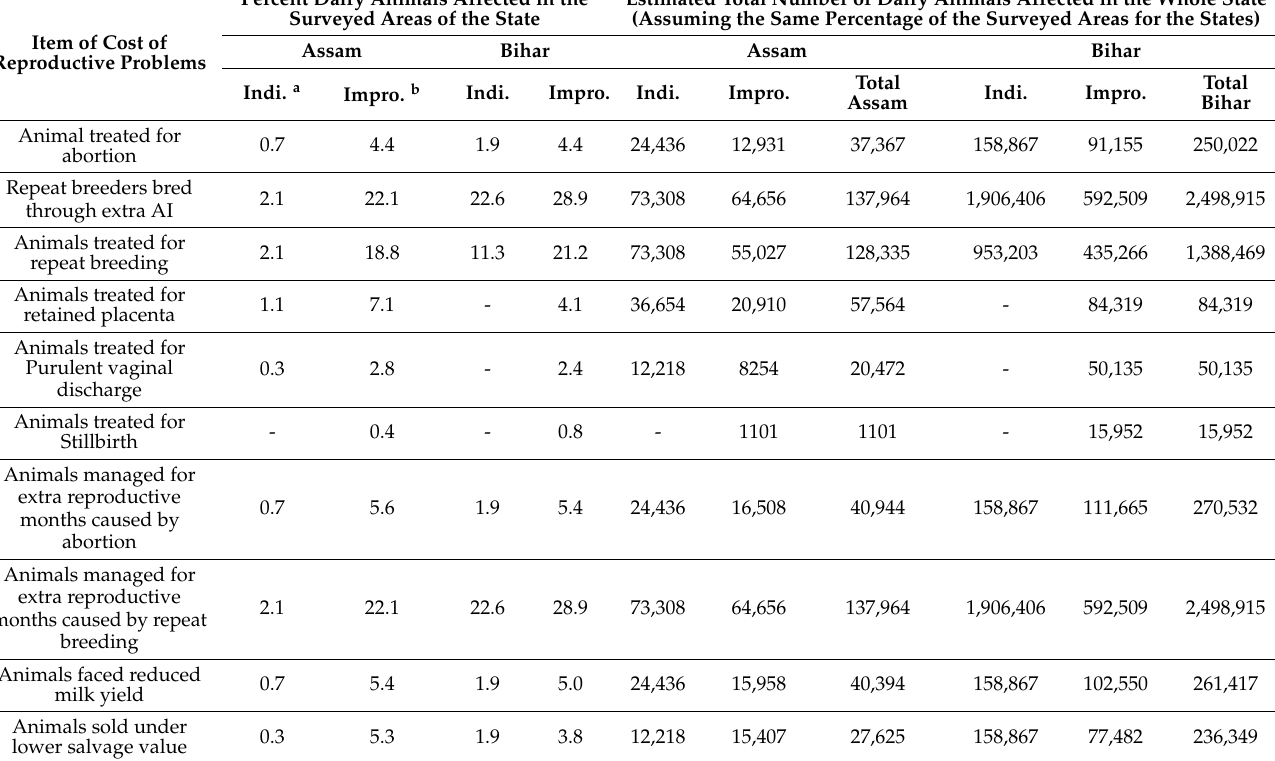
dry and heifer) in Assam ( n = 3,738,775) and Bihar ( n = 10,473,230) as per the 20th livestock census conducted in 2019. In Assam, 92.2% ( n = 3,445,483) of dairy animals were indigenous and the remaining 7.8% ( n = 293,292) were improved, while in Bihar, 80.4% ( n = 8,419,959) were indigenous and the remaining 19.6% ( n = 2,053,271) were improved. In Bihar, the total dairy animal population was 73.7% higher than in Assam, and the improved dairy animal population was 87.5% higher than in Assam. Table 4. Percent dairy animals affected in surveyed areas and estimated numbers of total dairy animals affected in the whole state. Percent Dairy Animals Affected in the Estimated Total Number of Dairy Animals Affected in the Whole State Surveyed Areas of the State (Assuming the Same Percentage of the Surveyed Areas for the States) Assam Bihar Assam Bihar Indi. a Impro. b Indi. Impro. Indi.